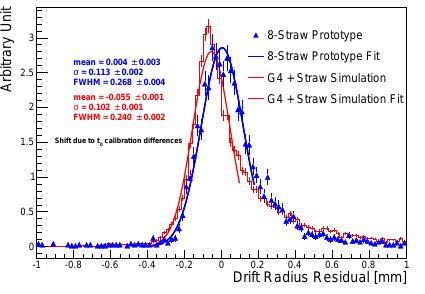
Figure 7. (Left) Comparison between data and MC position res- olution for the tracker prototype as evaluated with cosmic rays.